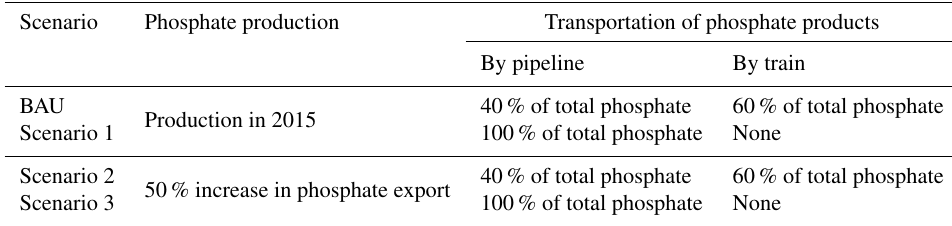
Table 5. Scenarios through combination of production and transportation system.